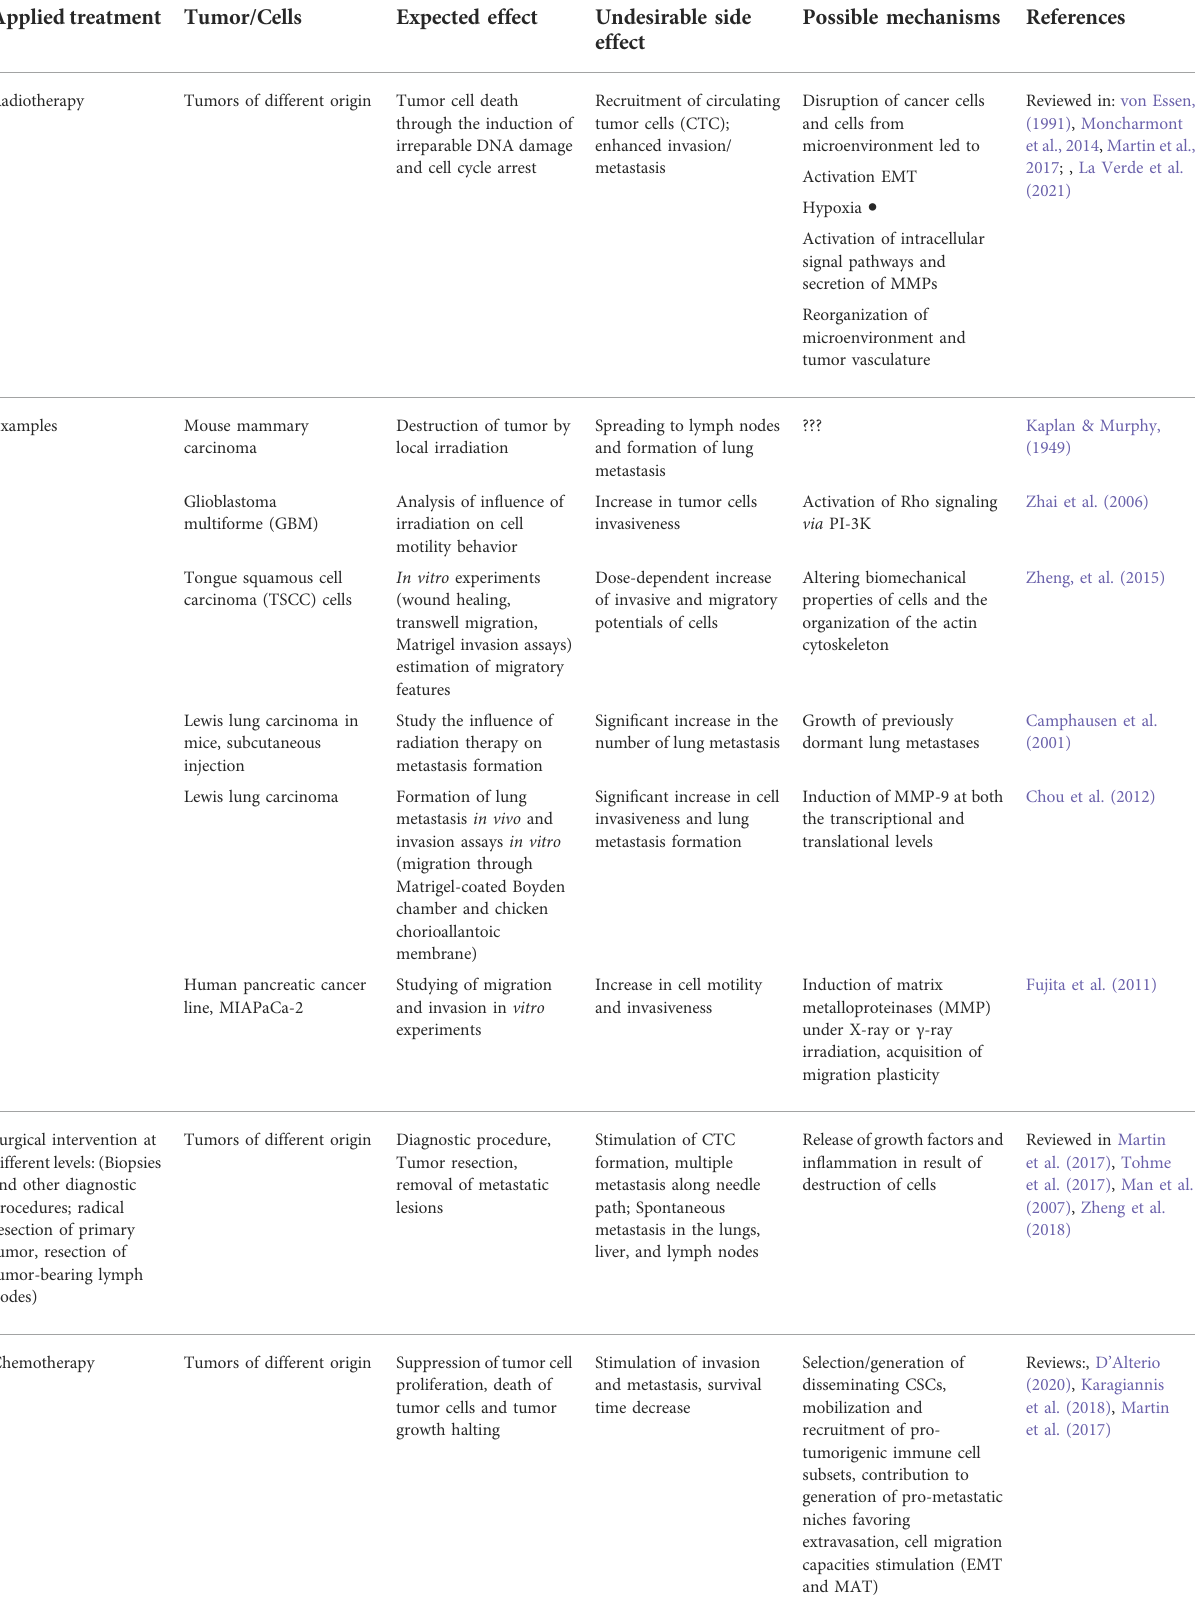
TABLE 1 Examples of the induction of metastatic tumor potential under the in fl uence of different therapeutic treatments. Applied treatment